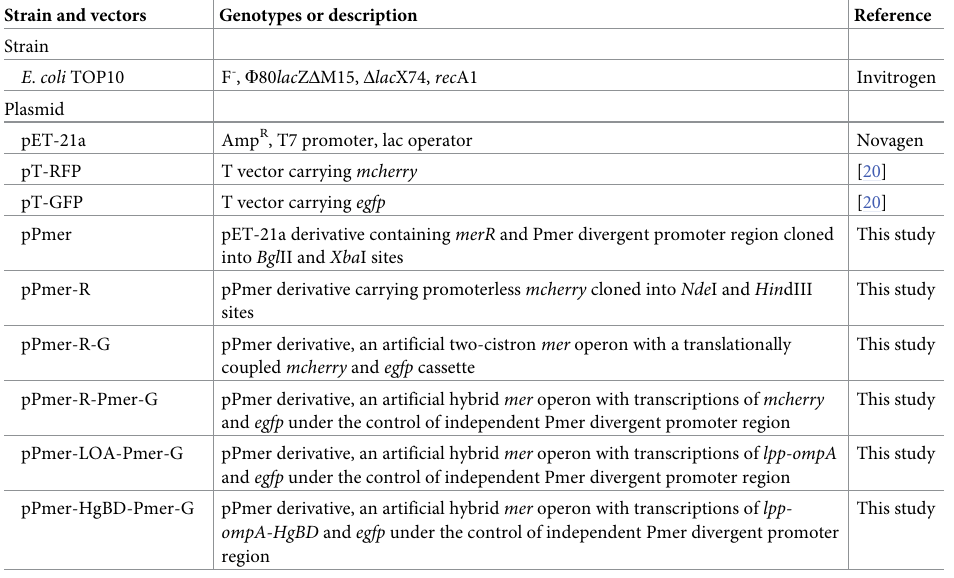
Table 1. Bacterial strain, plasmids, and primers used in this study.